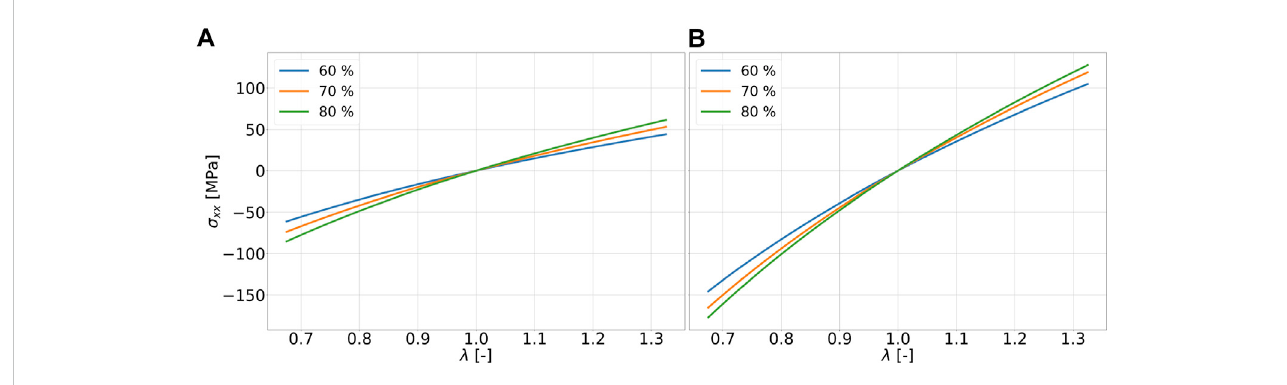
FIGURE 5 Fit of stress-strain data with the Ogden model of for 60 percent (blue), 70 percent (orange), 80 percent(green) cdc for ratio 2 to 1 and strain rates (A) 10 8 1/s and (B) 10 9 1/s.